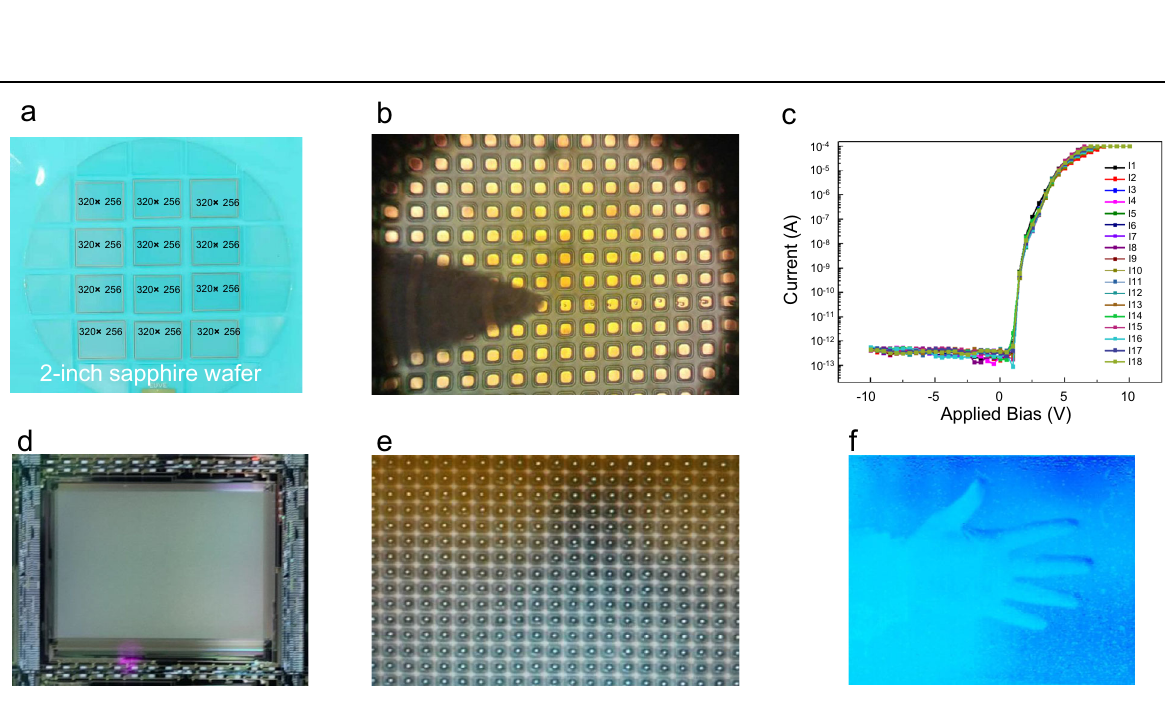
Fig. 18 320 × 256 AlGaN UV FPAs and imaging technology. a Schematic structure of the AlGaN photodetector. b Spectral response at 0 V. c Electrical arc discharge image from FPA camera. d Paper-cutout image from FPA camera. e SEM image of FPA with indium bump. f Schematic diagram of Imaging geometry. Reprinted with permission from McClintock et al. 267 . Copyright 2005 SPIE